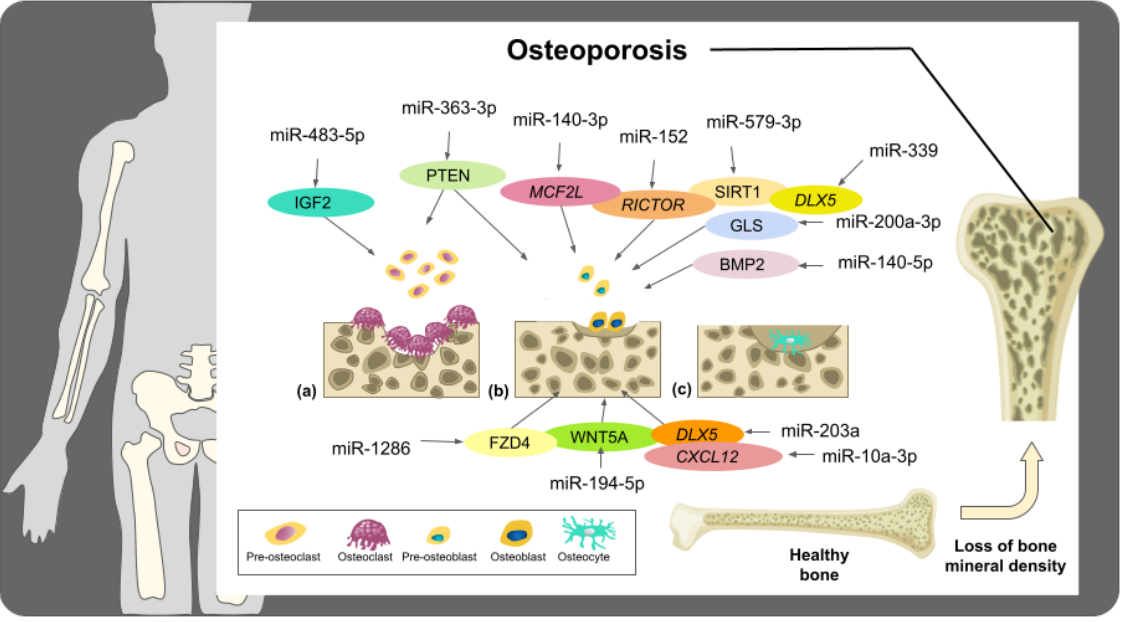
Figure 2. Schematic representation of some of the important miRNAs associated with osteoporosis progression. These miRNAs have been described as relevant regulators of targets associated with bone mineralization, osteogenic differentiation, and osteoclast differentiation. When bone resorption increases ( a ) and osteogenesis is restrained ( b ), osteocyte lacunae decrease ( c ), which subsequently drives to the loss of bone mineral density and the occurrence of osteoporosis.